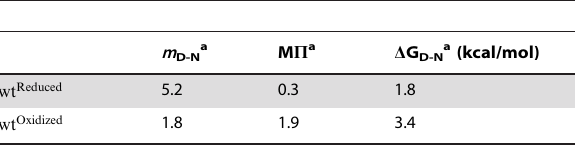
Table 2. Experimental data from equilibrium curves of wt and mutated